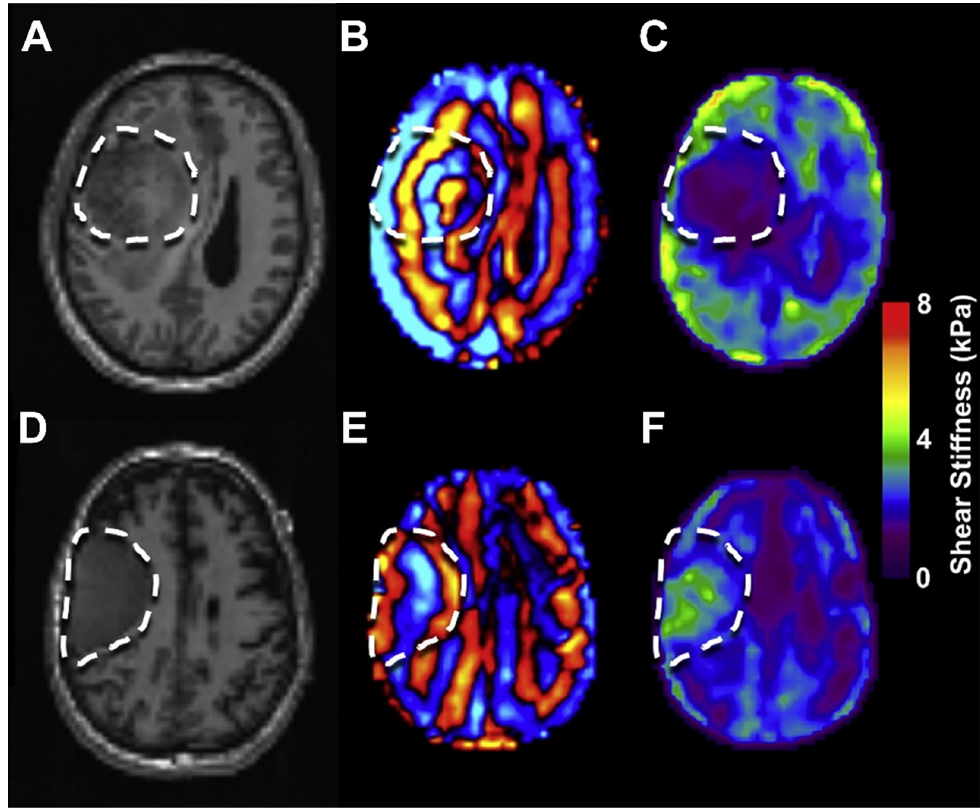
Figure 3. Tumor stiffness differences for two patients with meningiomas. T2-weighted anatomical images ( A , D ), curl wave images ( B , E ) and elastograms ( C , F ). The first patient ( A , B , C ) had a substantially softer meningioma than the second one ( D , E , F ). In the first example, the shear wavelength is much shorter than in the second one. Figure adapted with permission from Ref. [108]. 2015, Pepin K.